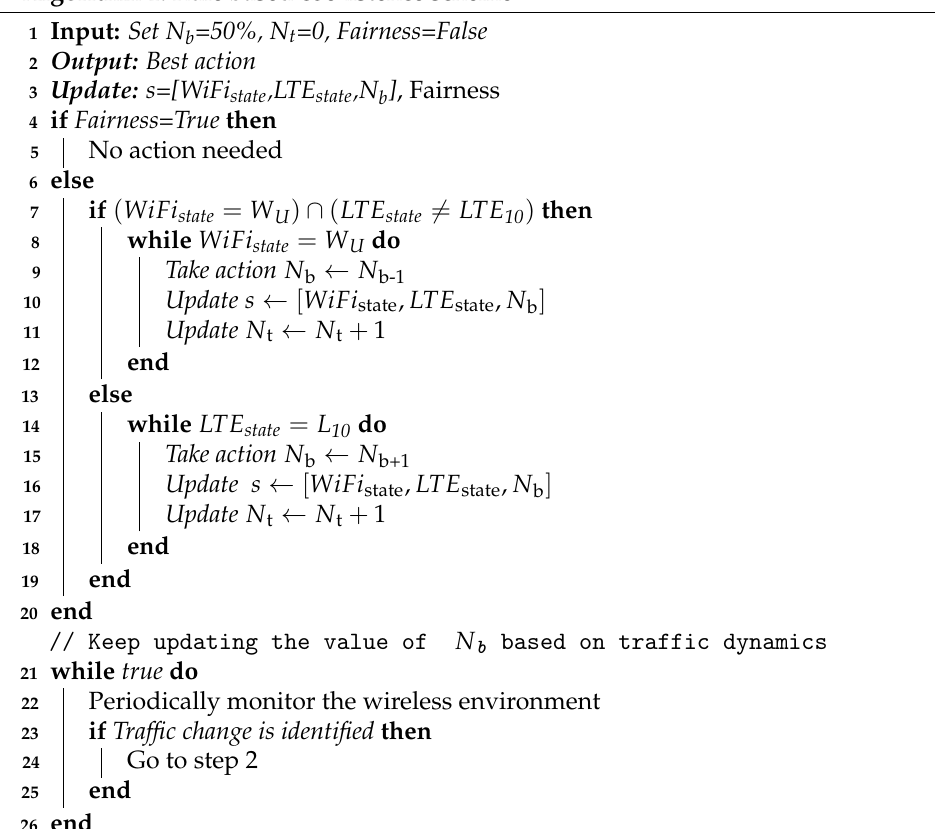
Algorithm 1: Rule based coexistence